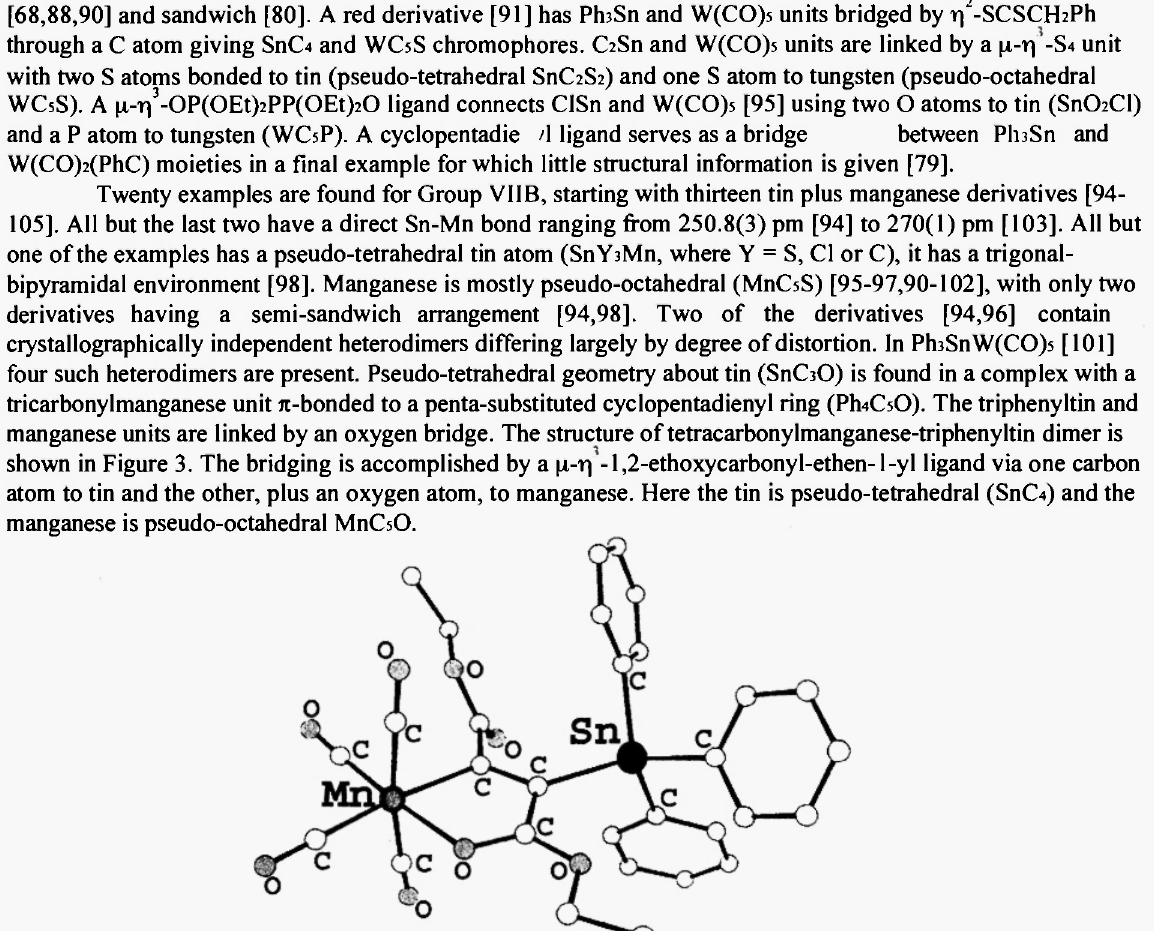
Figure 3. Structure of Ph3Sn^-Et0(C(0)CHCHC(0)0Et}(Mn(C0)4]